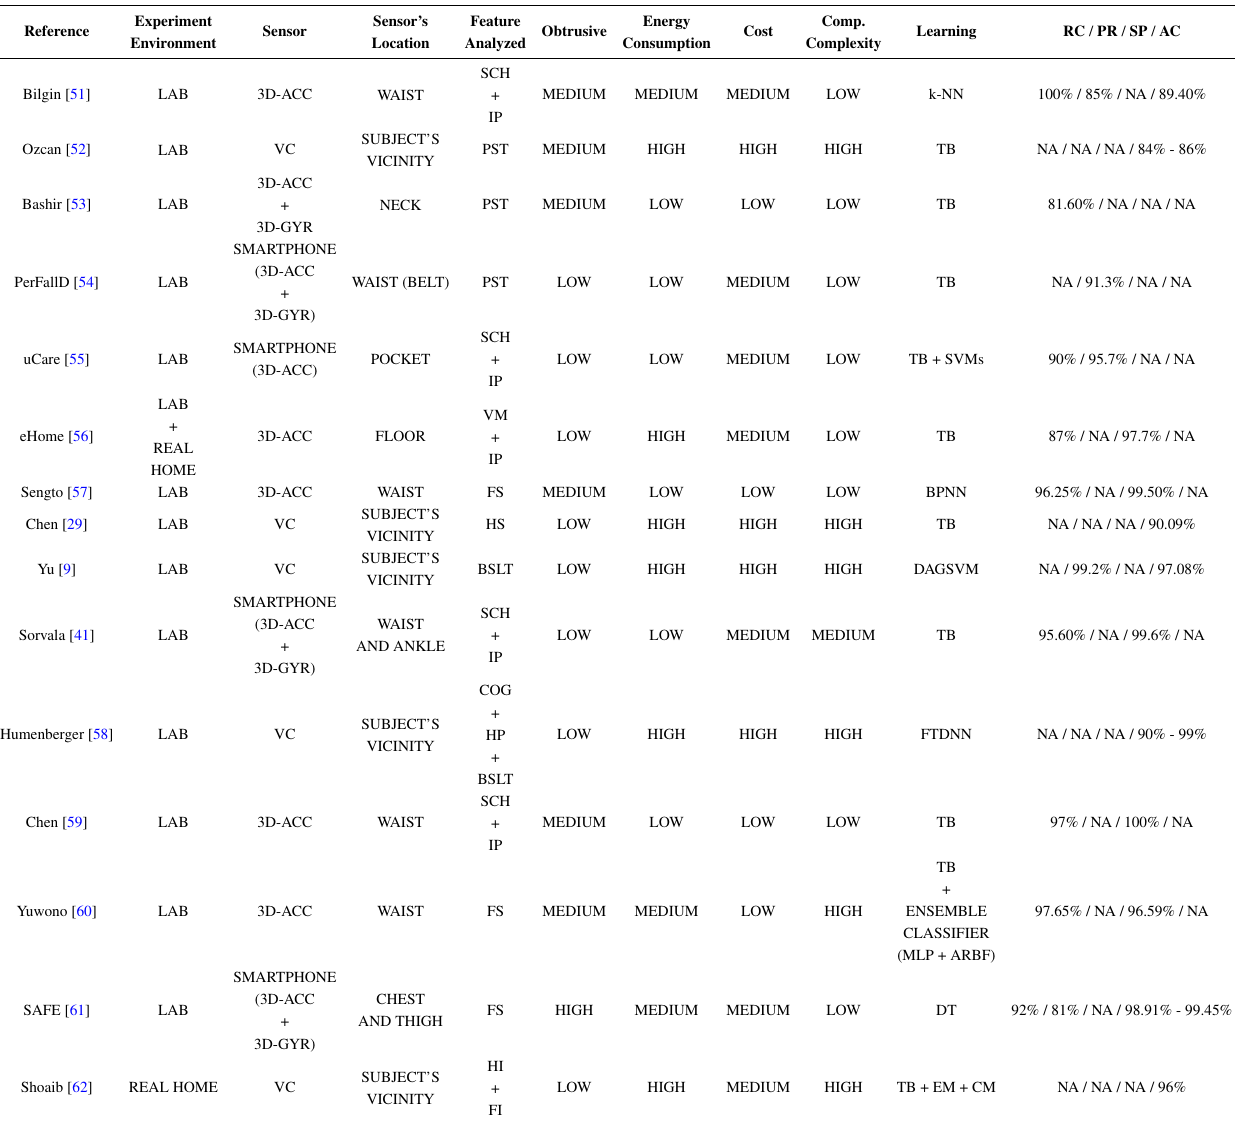
Table 4. Summary of state-of-the-art fall detection